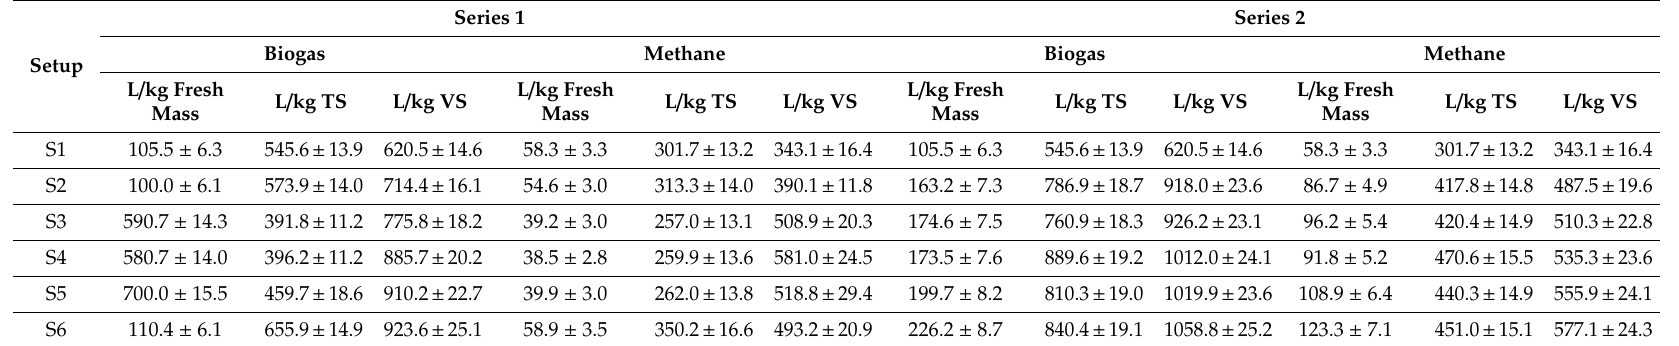
Table 5. Biogas production in experimental setups (S).